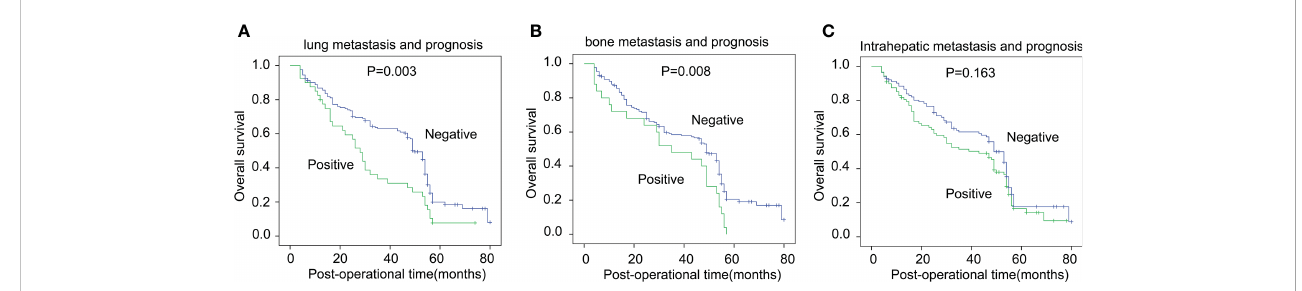
FIGURE 3 The correlation between asynchronous metastases and OS rates. The correlation between asynchronous metastases of the lung (A) , bone (B) , liver (C) , and OS rates was analyzed with the log-rank